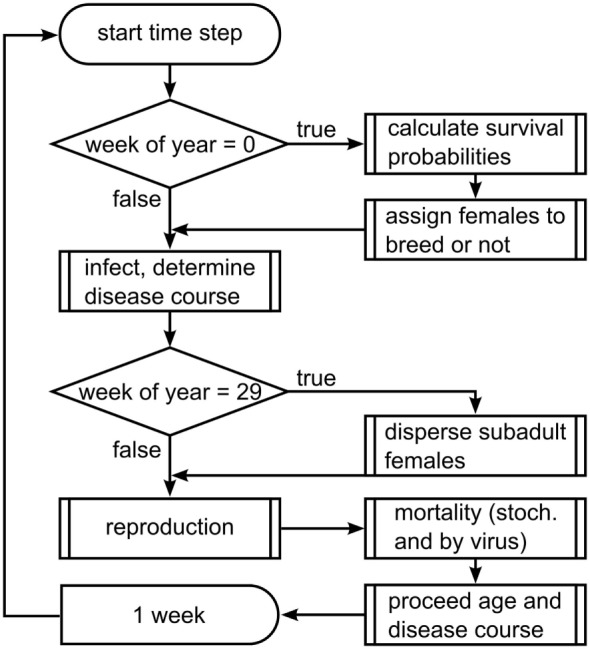
Flow chart of the scheduling of submodels.